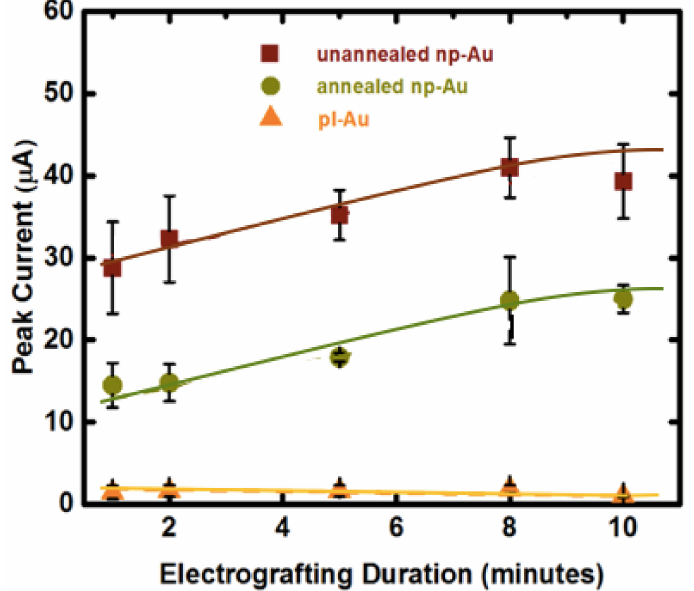
Figure 3. Effect of electrode morphology (unnanealed, annealed np-Au and pl-Au) and electro-grafting duration (1, 2, 5, 8, 10 min) on the peak current (surrogate for immobilized probe amount deducted from square wave voltammetry (SWV) measurements). SWV were taken at 18 Hz for unannealed np-Au, 30 Hz for annealed np-Au and 60 Hz for pl-Au after probe DNA immobilization (optimal frequency was determined previously [16]) at 10 mV/s scan rate. In contrast to the pl-Au electrodes, the np-Au electrodes require a longer electro-grafting duration to saturate the surface, as probe DNA needs to permeate the porous structure. The curve-fits are for visual guidance